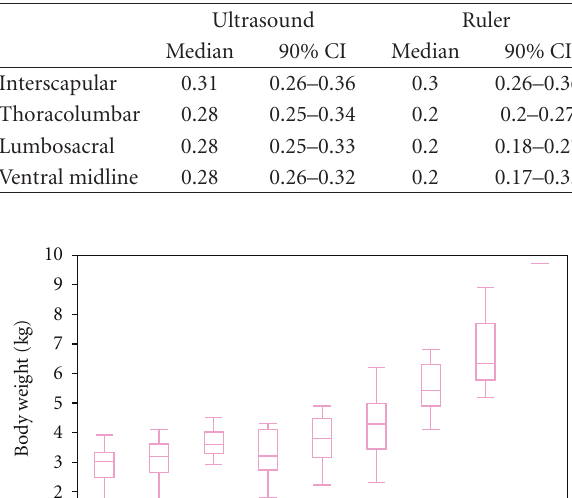
Table 1: Medians and 90% confidence intervals (in cm) for the pilot study comparing two fat depth measurement techniques at four locations ( n = 8).